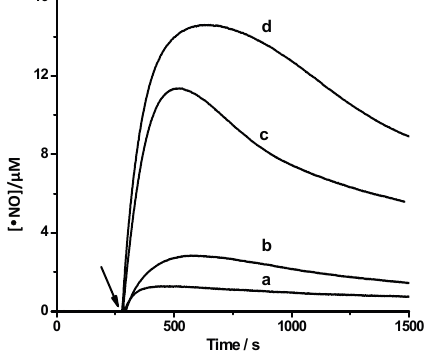
Figure 6. Production of  NO during the reaction of PGR with HONO. Time course of the  NO production upon addition of 100 µM HONO (arrow) in the absence ( line a ) and presence of PGR at final concentrations; 5 µM ( line b ); 30 µM ( line c ); 50 µM ( line d ). The solutions were incubated in SGM at 25